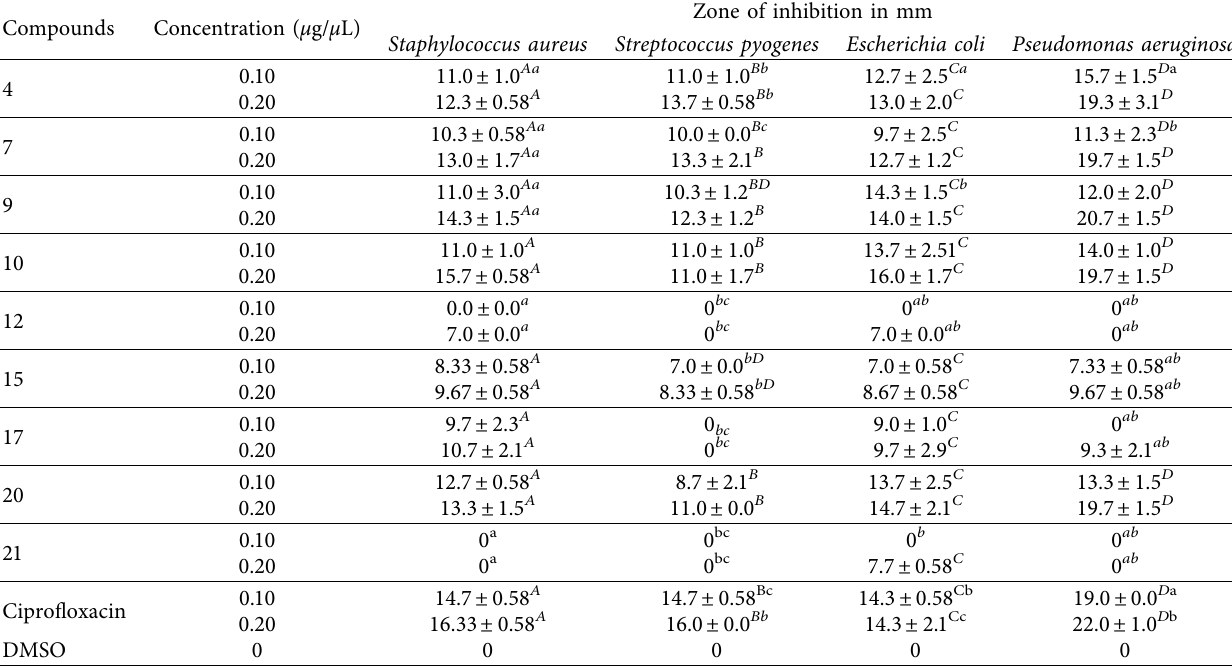
Table 1: The antibacterial activity of the synthetic